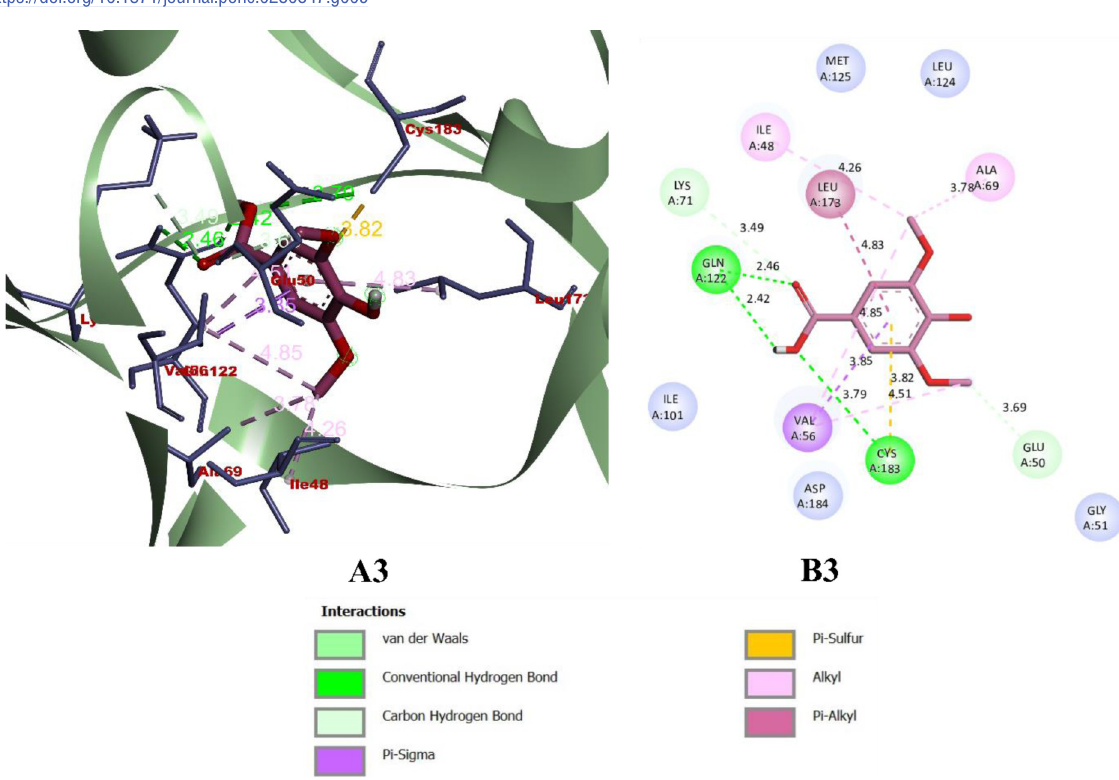
Fig 10. Arrangement (A3) and binding pattern (B3) of binding interactions of syringic acid from JME with the residues of human MAPK3 protein. https://doi.org/10.1371/journal.pone.0280847.g010 PLOS ONE | https://doi.org/10.1371/journal.pone.0280847 January 30,